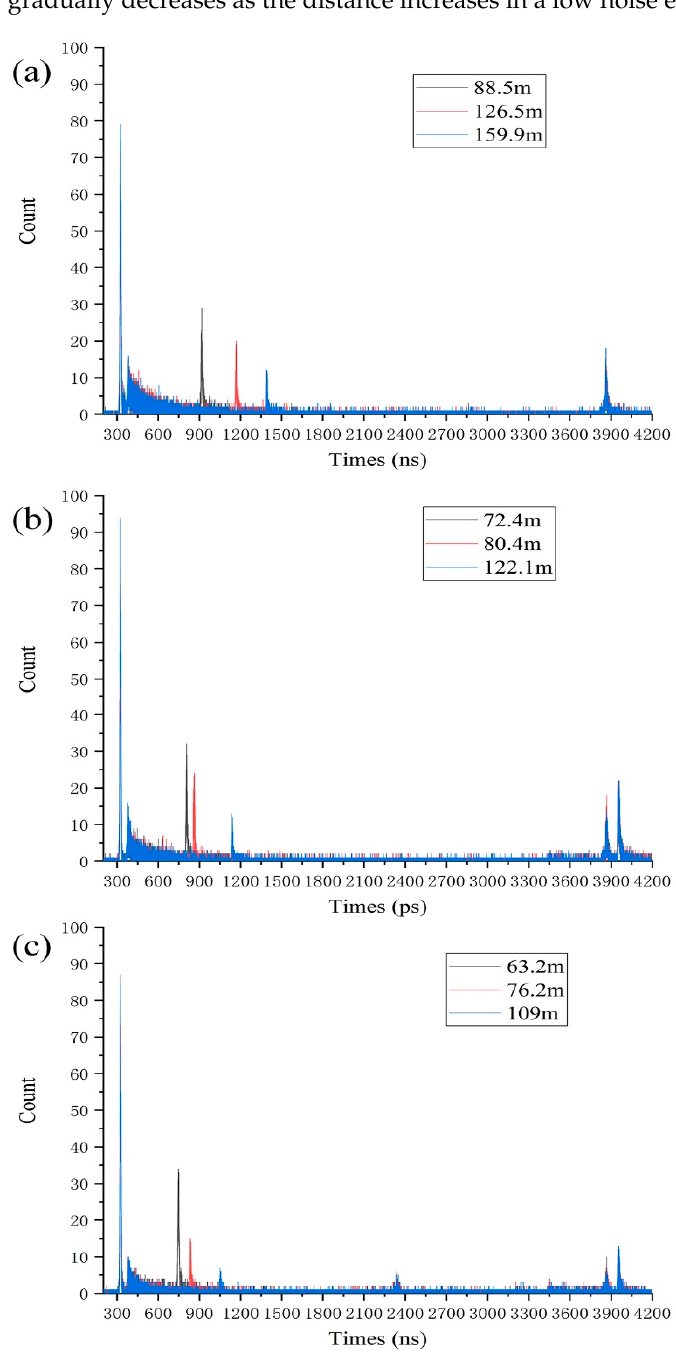
Figure 8. Search experiments with FOVs of ( a ) 32 mrad, ( b ) 160 mrad, ( c ) 220 mrad.